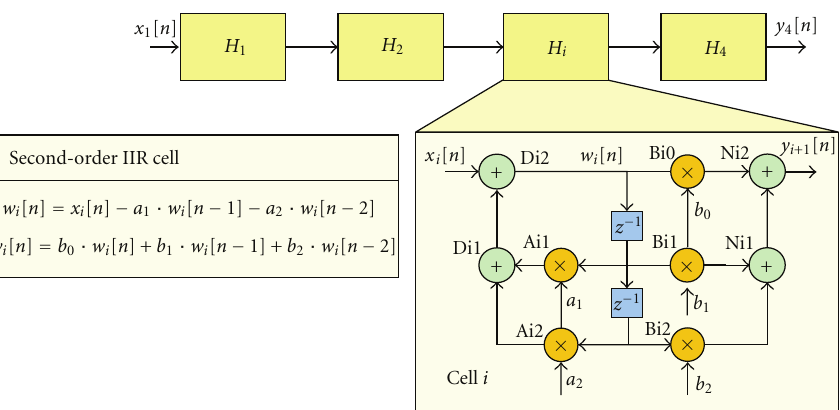
Figure 6: Signal flow graph of the 8th-order IIR